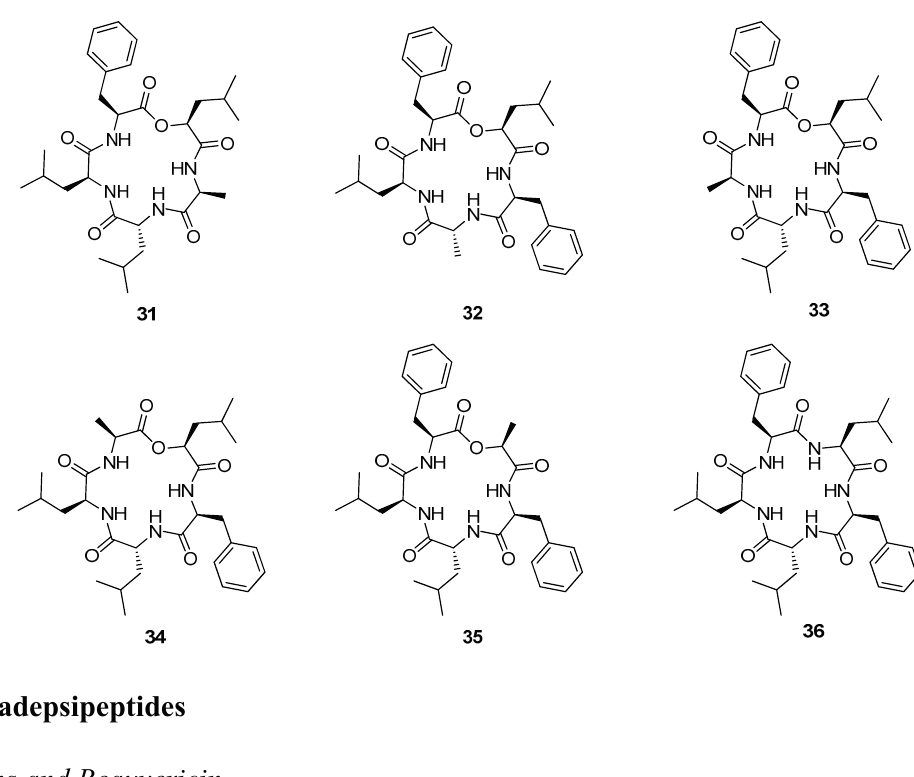
Figure 6. Structures of zygosporamide